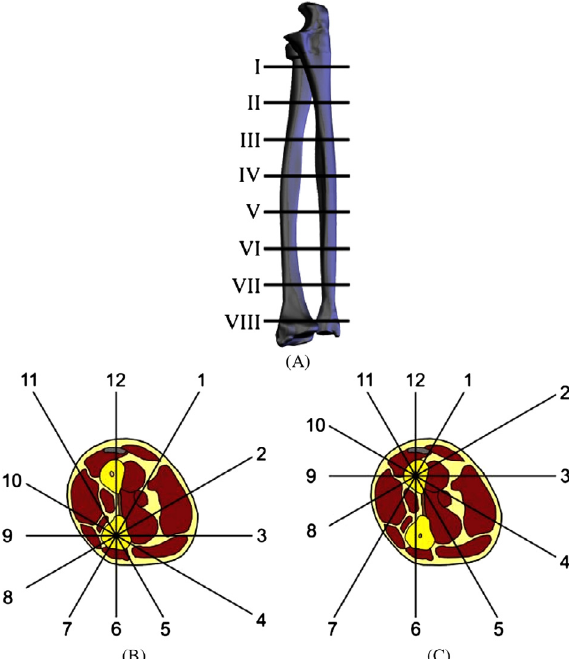
Figure 1. (A) Diagram of forearm division into eight principal levels according to MUDEF system of coordinates. (B) Forearm, level IV: designation of positions relative to the ulnar bone. (C) Forearm, level IV: designation of positions relative to the radial bone.